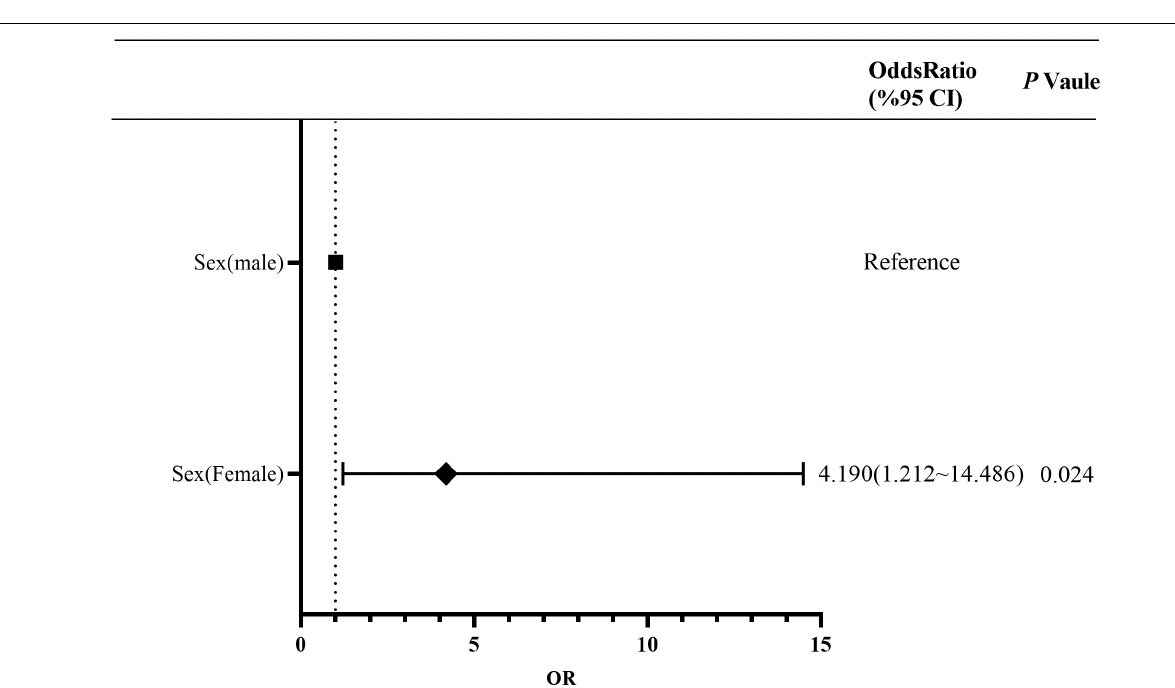
and cefepime were 84.4, 87.5, 78.1, and 71.9%, respectively. The resistance rates of P. aeruginosa to furadantin, co-trimoxazole, and ceftriaxone were higher than 90.0%, and the sensitivity rates to levofloxacin, amikacin, tobramycin, and gentamycin were more than 89%. E. cloacae demonstrated more than 80% sensitivity to levofloxacin, ciprofloxacin, amikacin, and cefepime. The remaining Gram-negative bacteria were more than